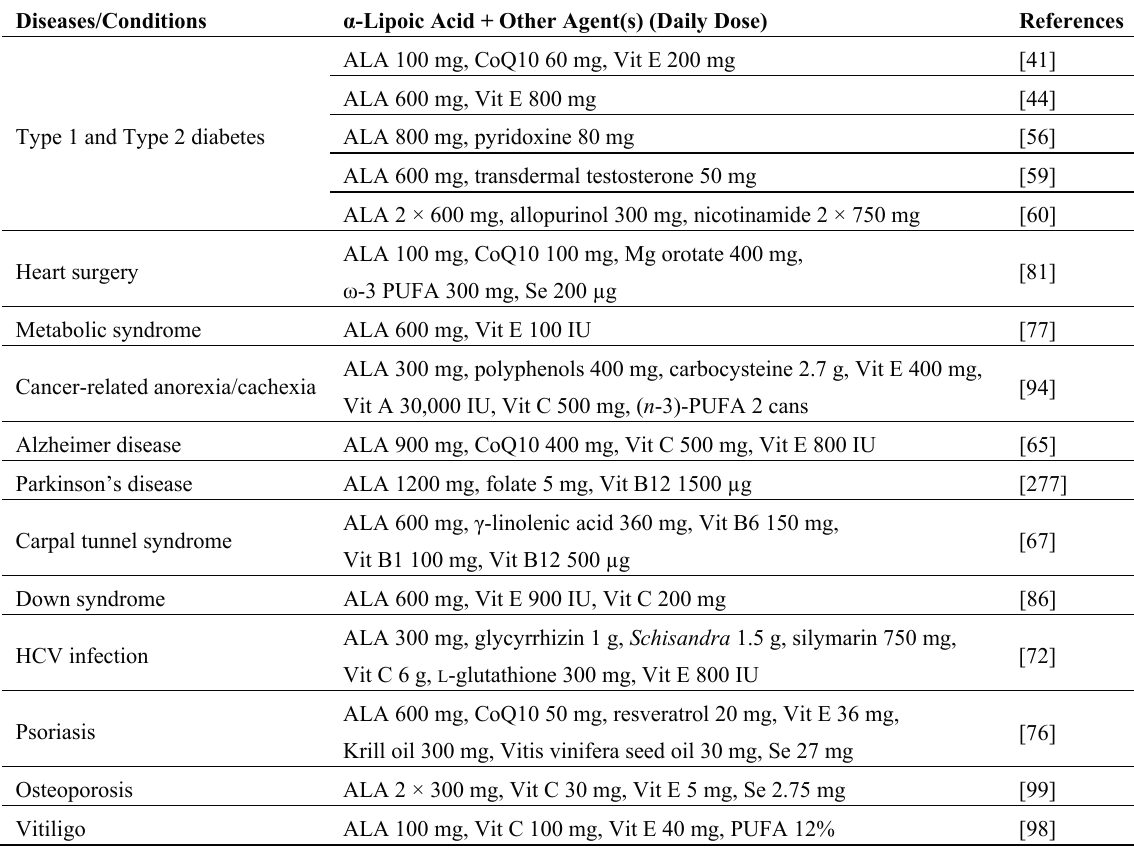
Table 5. Clinical studies utilizing mitochondrial nutrients and antioxidants and/or herbal compounds aimed at compensating OS/MDF-related pathogenetic mechanisms.